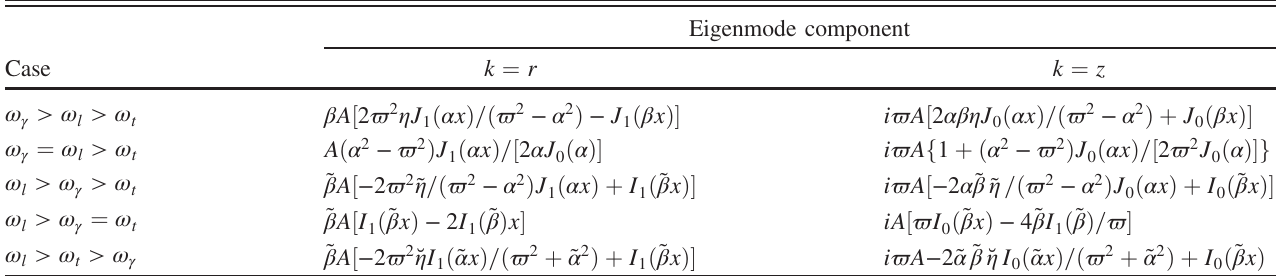
TABLE XIII. Longitudinal (L) fiber eigenmodes: Nonzero components of the radial partial wave of the displacement eigenmode. The amplitude A ∈ C can be obtained from the normalization condition (C14), all other quantities are defined in Table IX. These expressions are valid as long as M φ c ≠ 0 , that is, away from intersections with torsional bands. Otherwise, the displacement eigenmode can be obtained from the general expressions in Table X in conjunction with Eq. (C20).